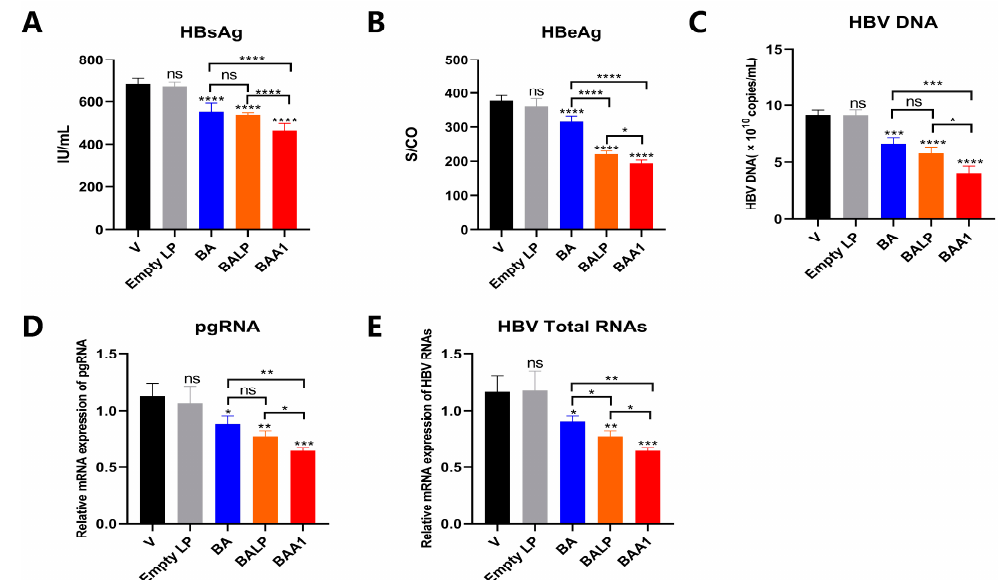
Figure 5. ApoA1 modification enhanced the anti-HBV effects of BA liposomes. pHBV1.2-transfected HepG2 cells were treated with empty liposomes (LP), BA liposomes (BALP, 50 µ M), BA (50 µ M), and BAA1 (50 µ M) for 2 days. ( A , B ) HBsAg and HBeAg in the culture supernatants were detected by using ELISA kits. ( C ) HBV-DNA (HBV virion) in the culture supernatants was detected by qPCR. ( D , E ) HBV total RNAs and pgRNA were determined by qRT-PCR. Data are presented as the mean ± SD, n = 3; * p < 0.05, ** p < 0.01, *** p < 0.001, and **** p < 0.0001 vs. control. ns, not significant.